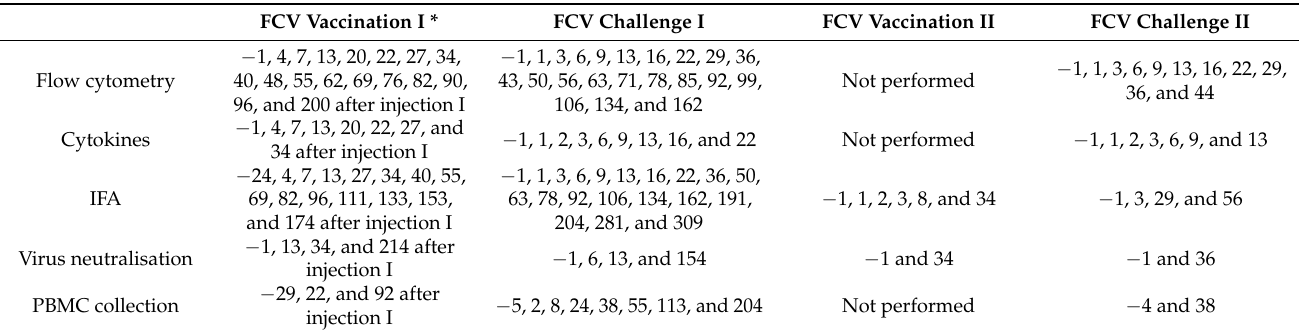
Table 1. Timepoints of blood collections for flow cytometry, cytokines, immunofluorescence assays (IFA), virus neutralisation, and peripheral blood mononuclear cells (PBMCs) collection for enzyme-linked immunospot (ELISpot) assay after FCV Vaccination I and II and FCV Challenges I and II